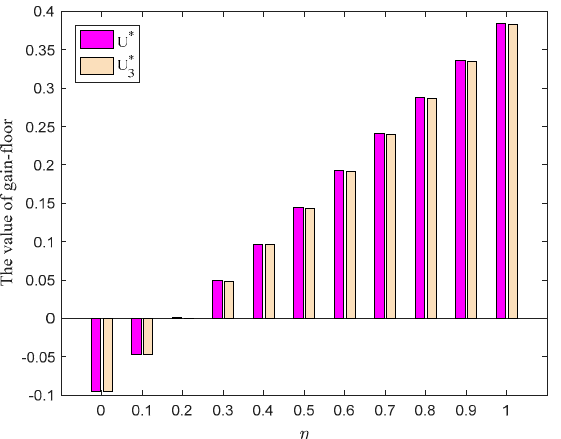
∗ and U ∗ with parameter η varying from 0 to U ∗ with parameter η varying from 0 to 1. Figure 13. The gain-floor U 3 3 U ∗ with parameter η varying from 0 to 1. 3